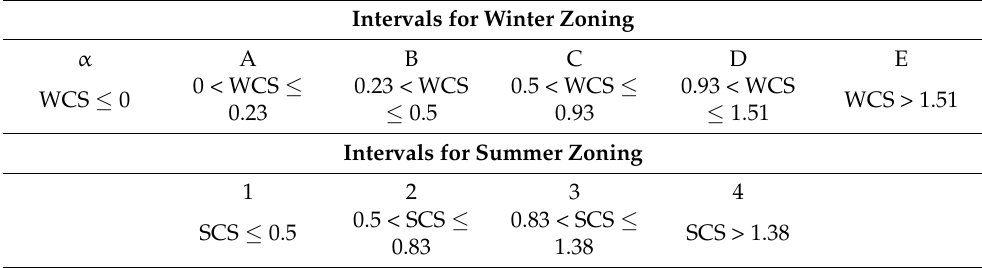
Table 1. Intervals for climate